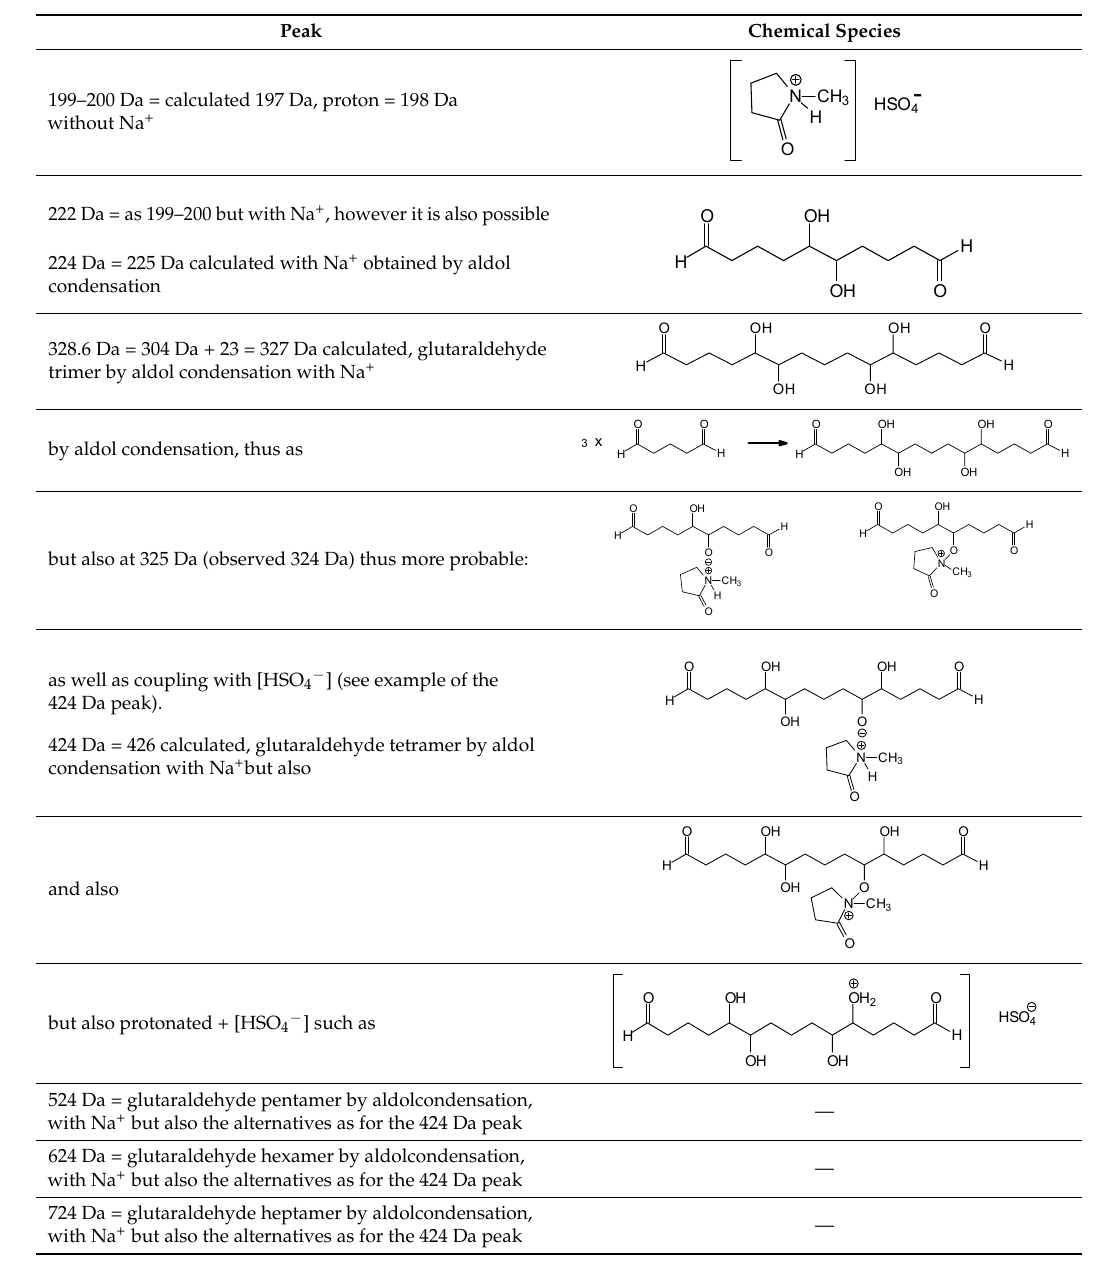
Table 4. Species formed by the reaction of glutaraldehyde with IL, by MALDI. Peak Chemical species